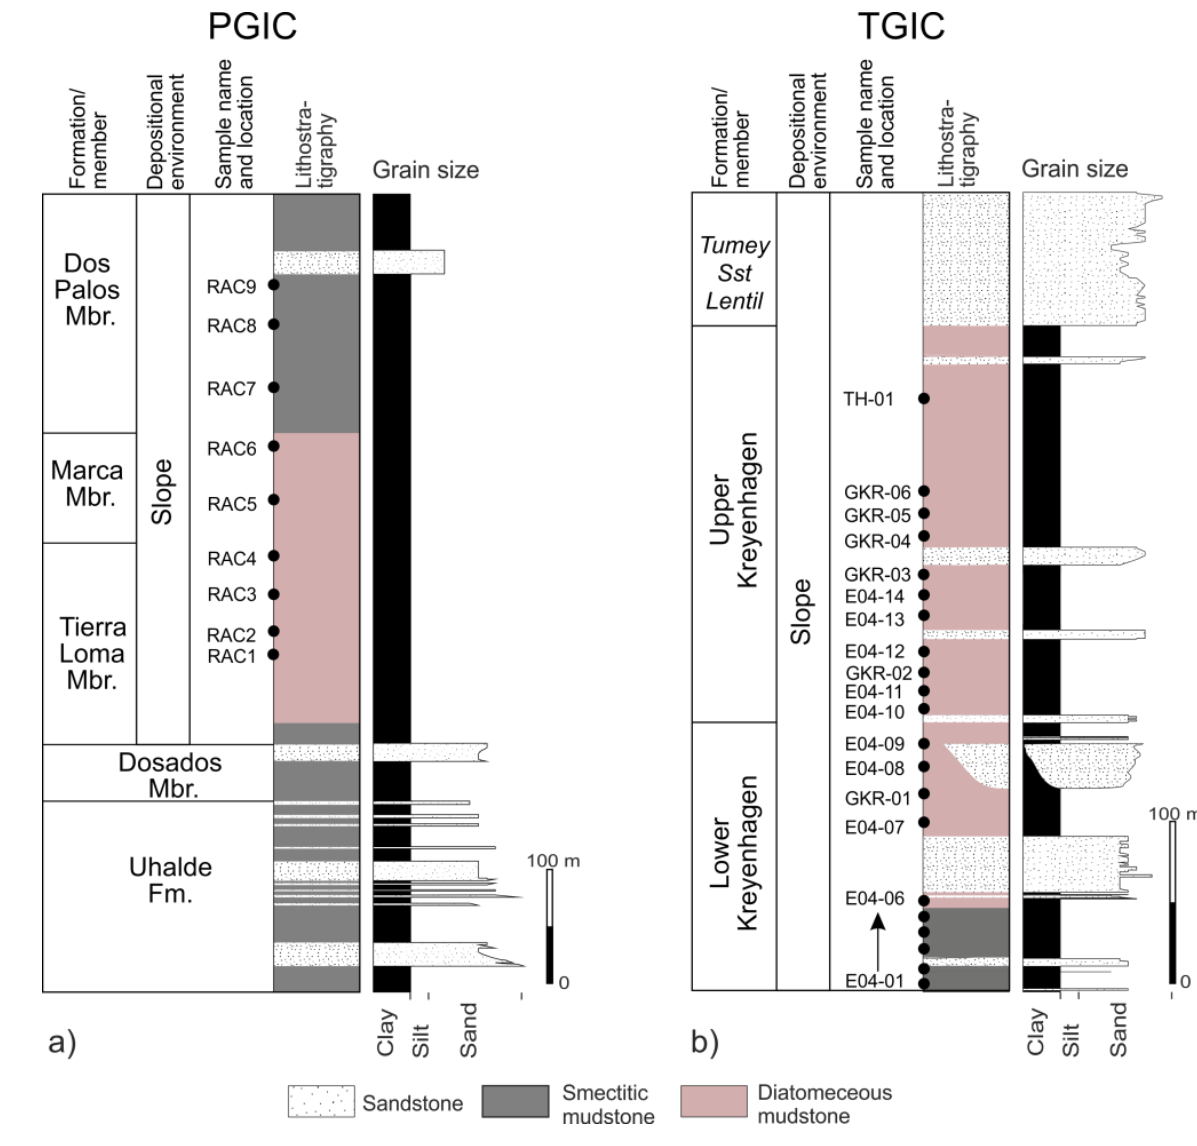
Figure 3. Simplified vertical sections through ( a ) the PGIC and ( b ) the TGIC; see Figure 1 and Figure 2 for locations. Sample locations are marked.